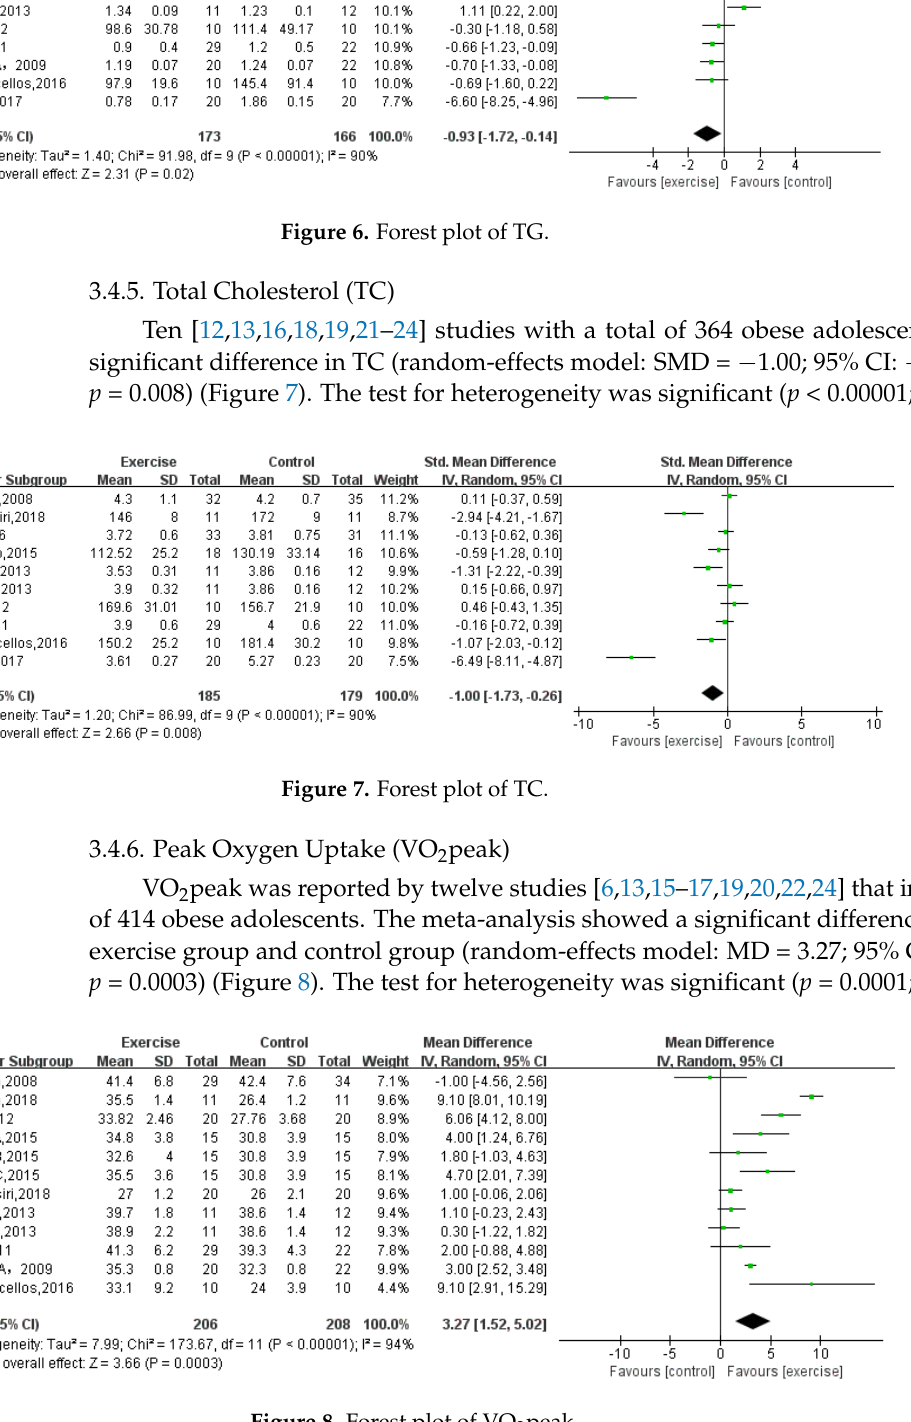
Figure 9. Forest plot of HOMA-IR. 3.4.8. Subgroup Analyses Subgroup analyses, based on exercise modality and intervention duration, were per- formed to explore heterogeneity and the separate effects of different exercise modalities and intervention durations (Table 3). The results of the subgroup analyses showed that exercise modality and intervention duration were not the potential factors that led to het- erogeneity for the outcomes of BMI, HDL-C, LDL-C, TG, TC, VO 2 peak, and HOMA-IR. Table 3. Subgroup analyses in obese adolescents. Outcomes